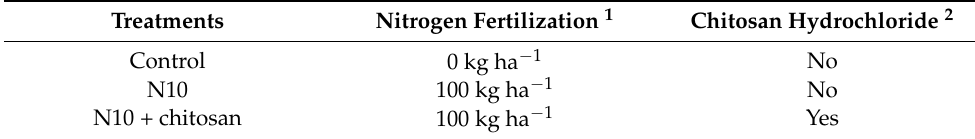
Table 1. Fertilization and chitosan treatments conducted in experiment 2.